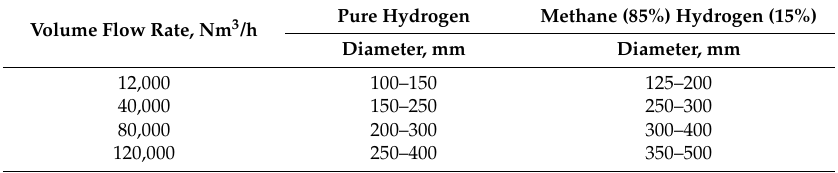
Table 1. Recommended pipeline diameters for pure hydrogen and methane/hydrogen mixture